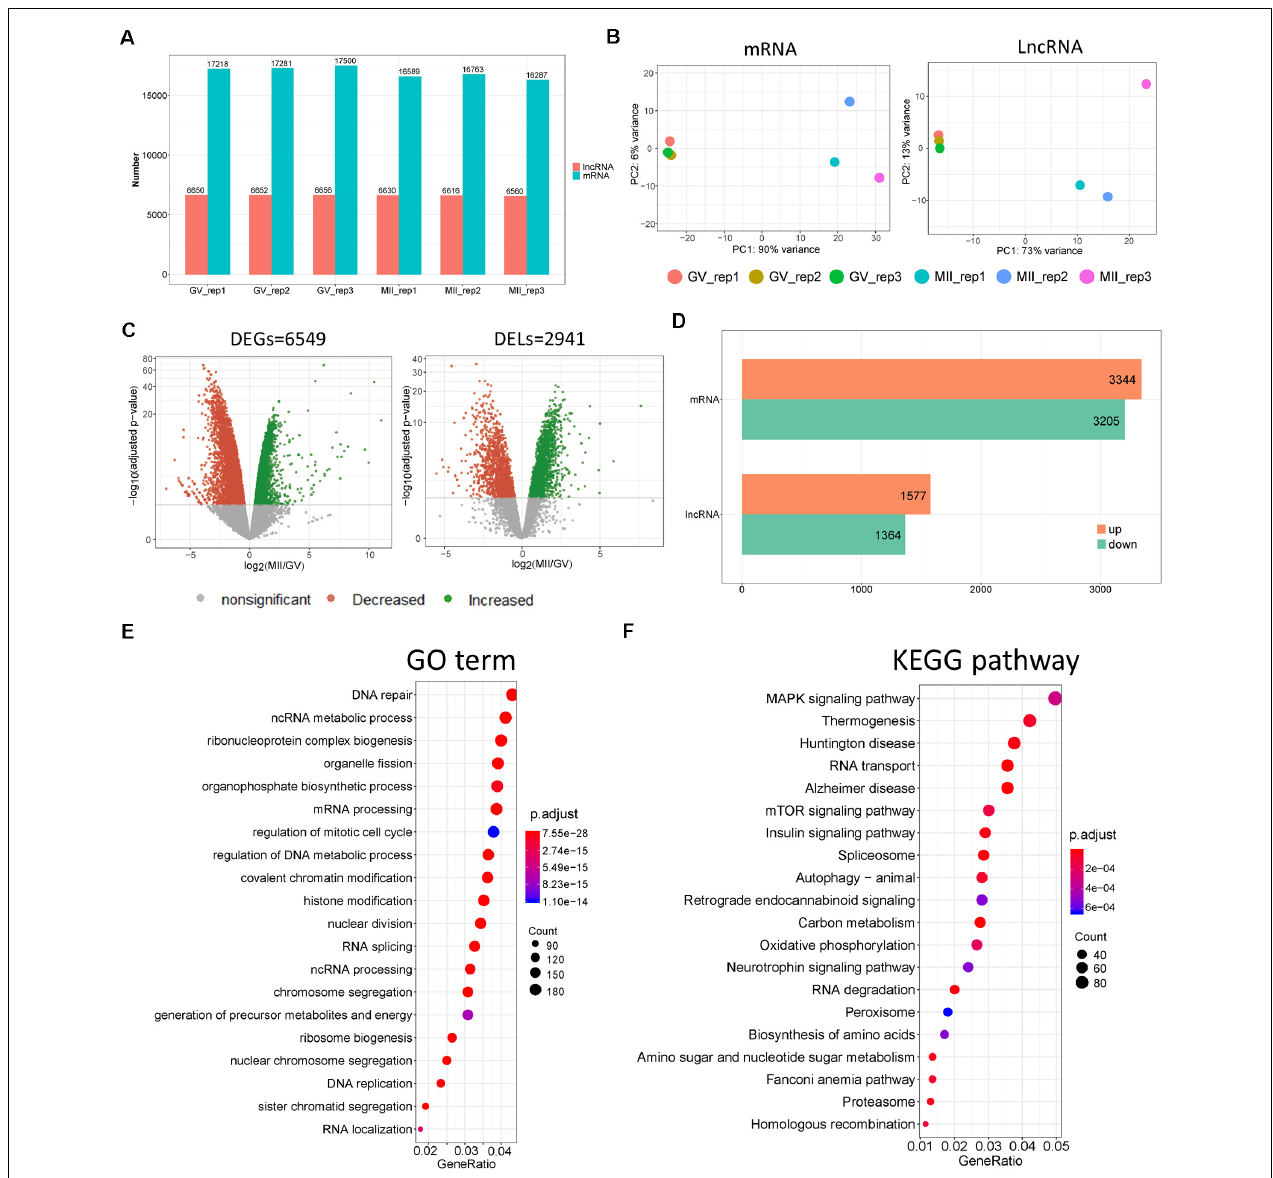
FIGURE 2 | Divergent expression patterns of lncRNA and mRNA in ovine oocytes. (A) Number of lncRNA and mRNA transcripts with a non-zero count in each sample. (B) Principal component analysis (PCA) based on lncRNA and mRNA. (C) Volcano plots of differentially expressed genes (DEGs) and lncRNAs (DELs) of MII vs. GV stages. (D) Number of upregulated and downregulated DEGs and DELs of MII vs. GV stages. (E) GO and (F) KEGG enrichment of DEGs with top 20 terms; “Count” is the number of DEGs that were enriched in the term; “GeneRatio” refers to the ratio of DEG numbers that were enriched in the term vs. all DEG